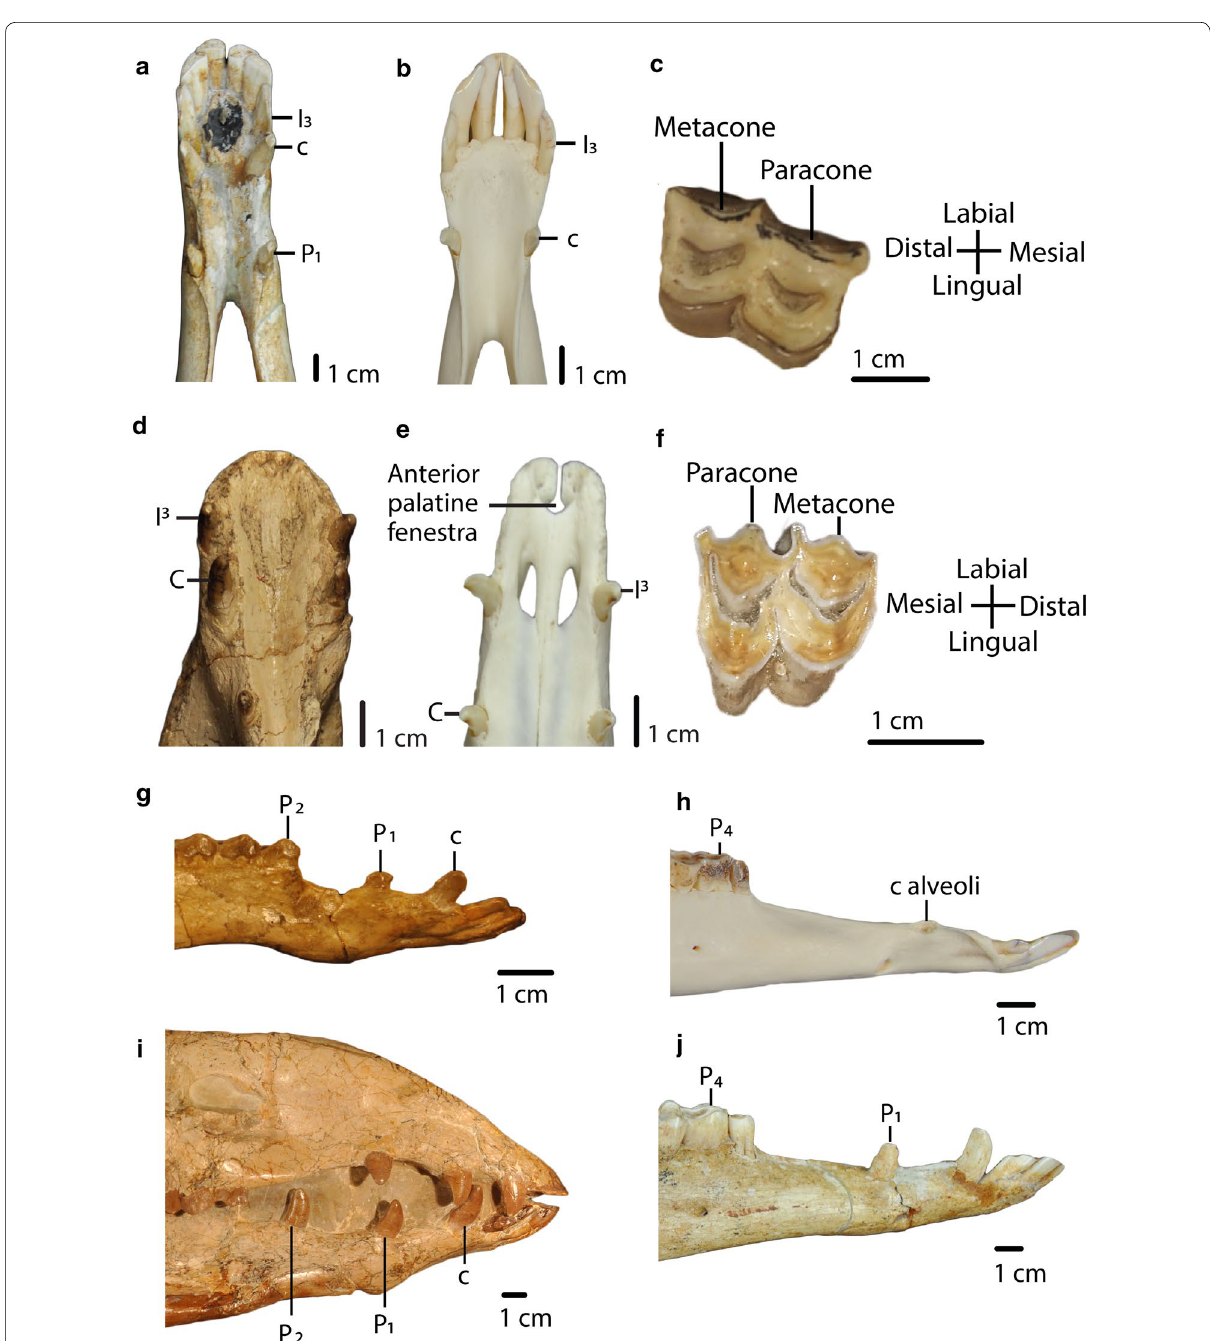
Fig. 4 a , b : Char. 7: “Lower canine position (c)”. a H. macrocephala (UF 205,750), scored close from incisor (I 3 ) (< 1 cm) (0). b L. guanicoe (ZM 17,209), scored far from incisor (I 3 ) ( 1 cm) (1). c , f : Char. 18: “Metacone and paracone on upper molars (M 1 ‑M 3 )”. c Right M 2 , P. coartatus (AMNH 73,377), ≥ scored weakly developed (0). f Left M 2 , P. weddelli (PUN 1), scored well developed (1). d , e : Char. 19: “Anterior palatine fenestra”. d P. coartatus (AMNH 73,438), ventral view, scored absent (0). e L. guanicoe (ZM 17,209), ventral view, scored present (1). g , h , i , j : Char. 9: “First lower premolar (P 1 )”. g P. wilsoni (AMNH 47,130), right side, scored premolariform (0). h L. guanicoe (ZM 17,967), left side, scored absent (2). i A. robustus (OMNH 016,560), right side, scored caniniform (1). j H. macrocephala (UF 205,750), right side, scored caniniform (1). g , h , i , j : Char. 11: “Second lower premolar (P 2 )”. g P. wilsoni (AMNH 47,130), right side, scored premolariform (0). h L. guanicoe (ZM 17,967), left side, scored absent (2). i A. robustus (OMNH 016,560), right side, scored caniniform (1). j H. macrocephala (UF 205,750), right side, scored absent